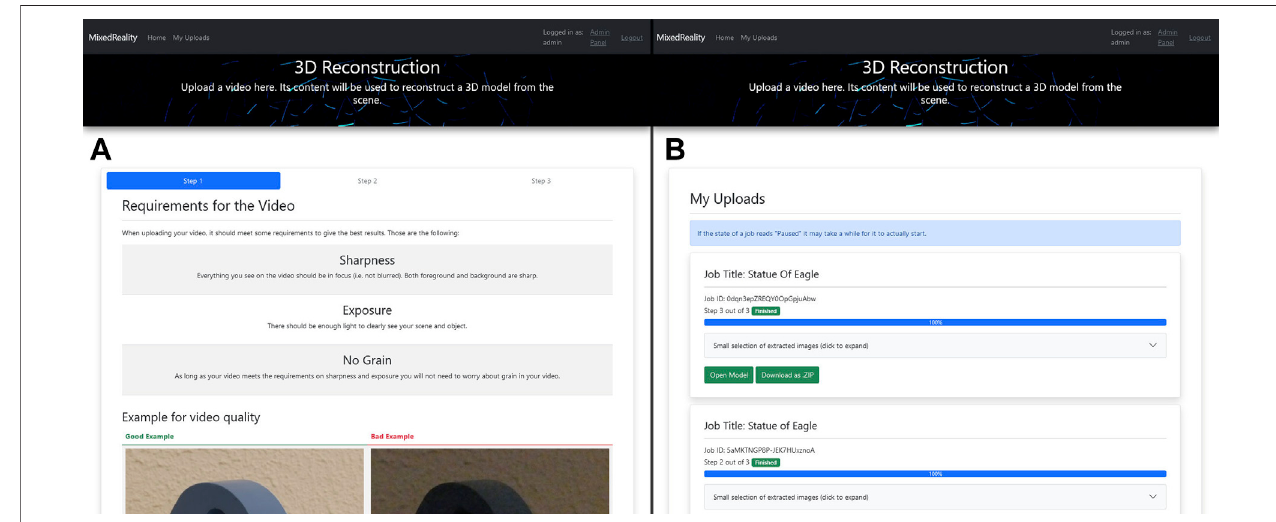
FIGURE 1 | Screenshots of the web interface. Start page (A) and overview of previous uploads (B) .